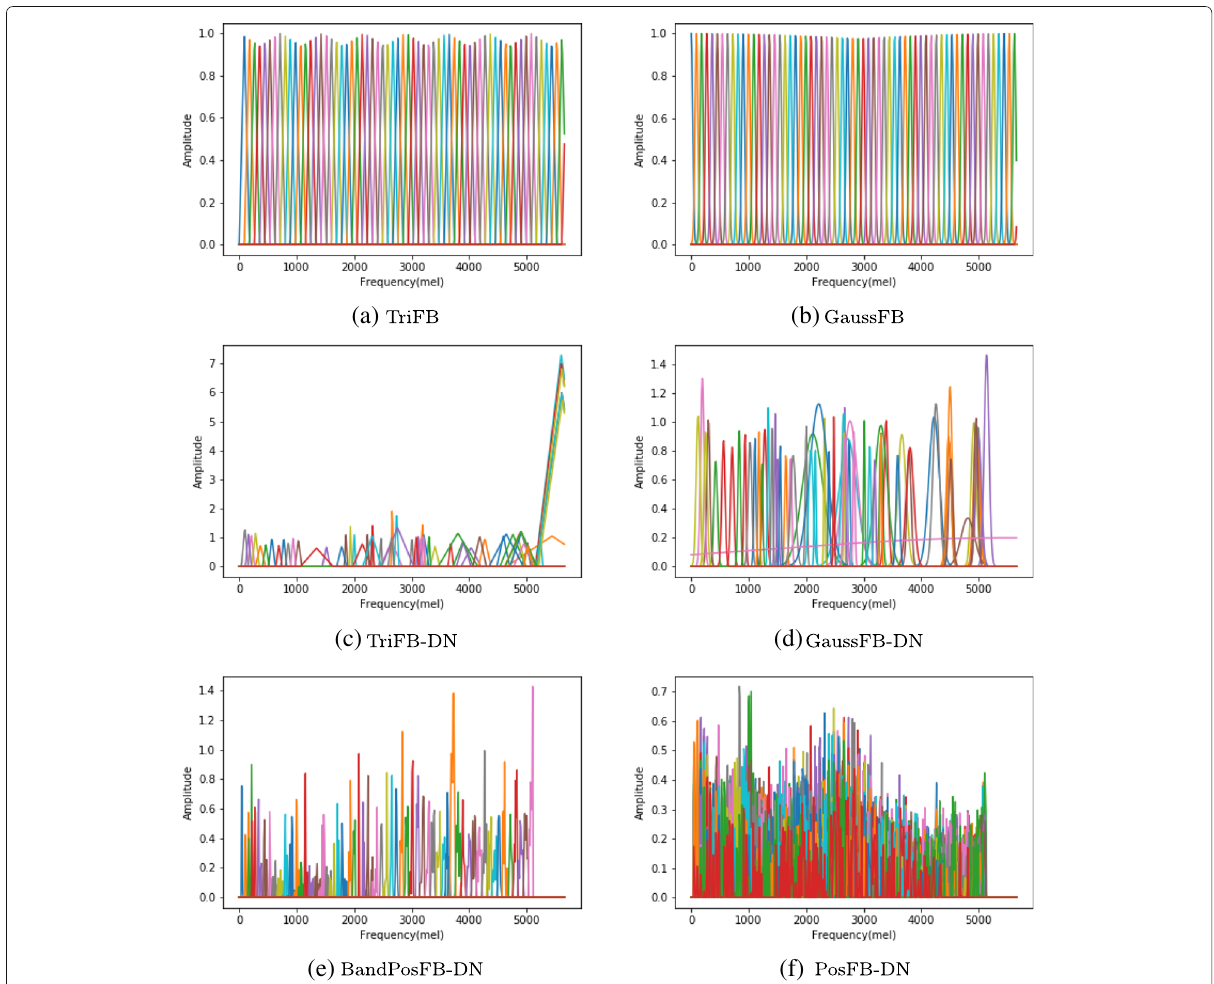
Fig. 5 Shape of different filter banks. a , b The traditional fixed-parameter filter banks. c – f The discriminative frequency filter banks we proposed and learned in the simple music spectrum reconstruction task